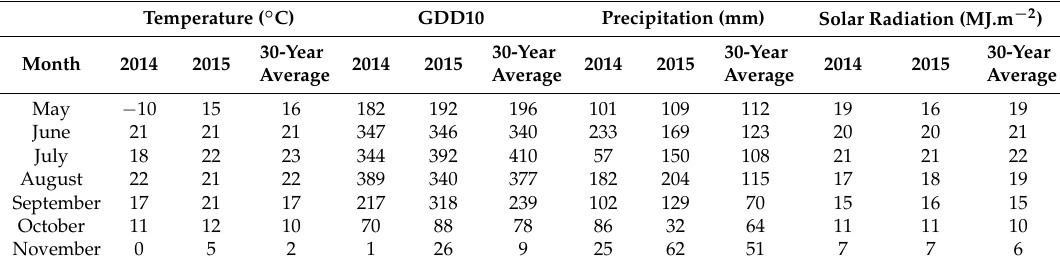
Table 1. Average monthly temperature, accumulated monthly growing degree days (GDD), precipitation, and solar radiation for 2014, 2015, and the 30-year average in Ames, IA.